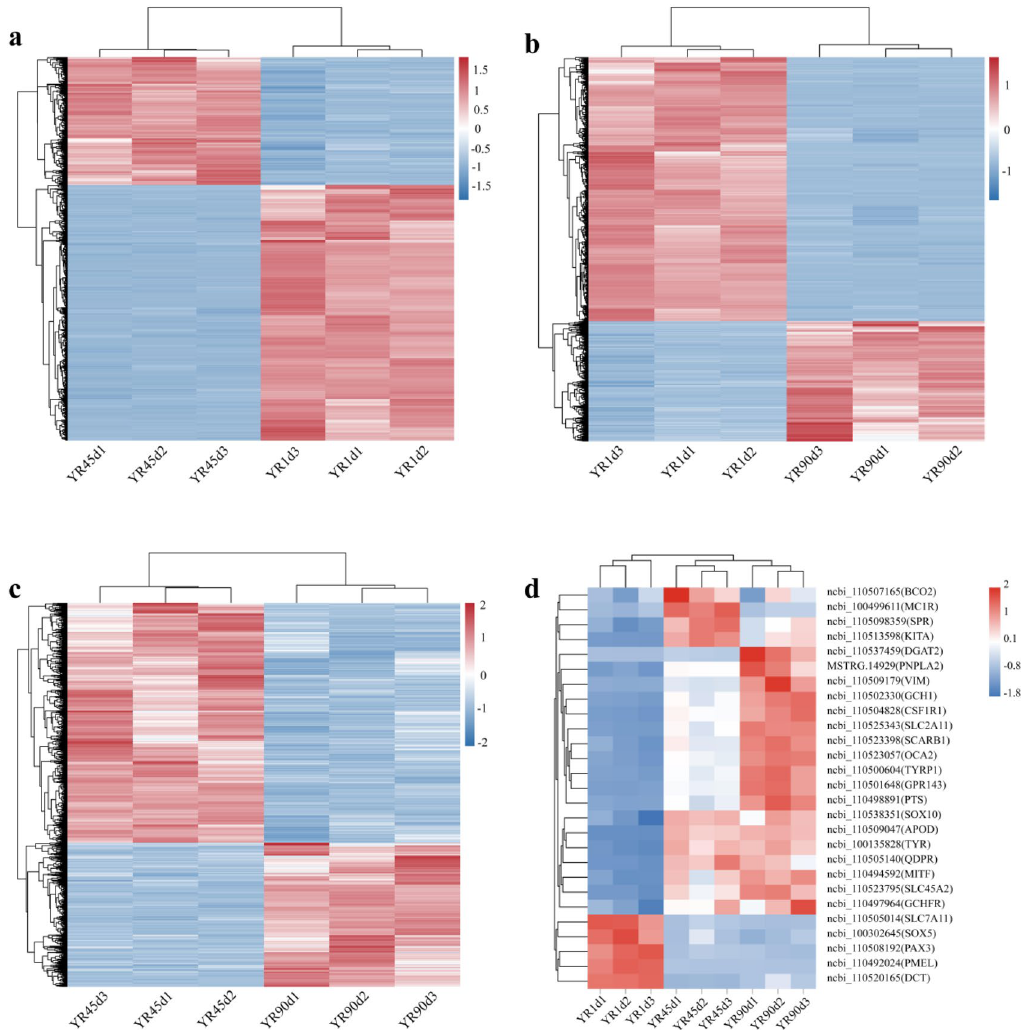
Figure 3. Heatmaps of expression levels of all DEGs and pigmentation-related genes among the three compared groups, representing three biological replicates. ( a ) YR1d vs. YR45d. ( b ) YR1d vs. YR90d. ( c ) YR45d vs. YR90d. ( d ) Pigmentation-related